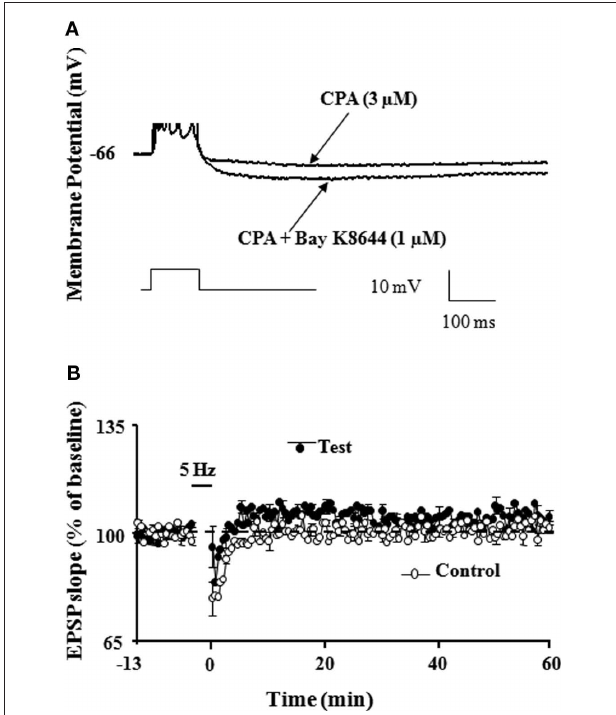
Figure 4 | enhance AHP amplitude during aging contributes to impaired LTP induction. (A) Representative intracellular current clamp recordings from a CA1 hippocampal pyramidal neuron in aged rat are shown after a train of five action potentials elicited by a 100-ms pulse of depolarizing current under conditions of CPA (3 μM) and following bath application of Bay K8644 (1 μM) in the presence of CPA. Note that under conditions of blockade of Ca 2 +